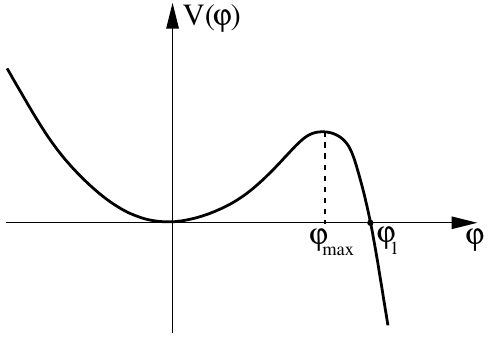
Figure 5. The toy model